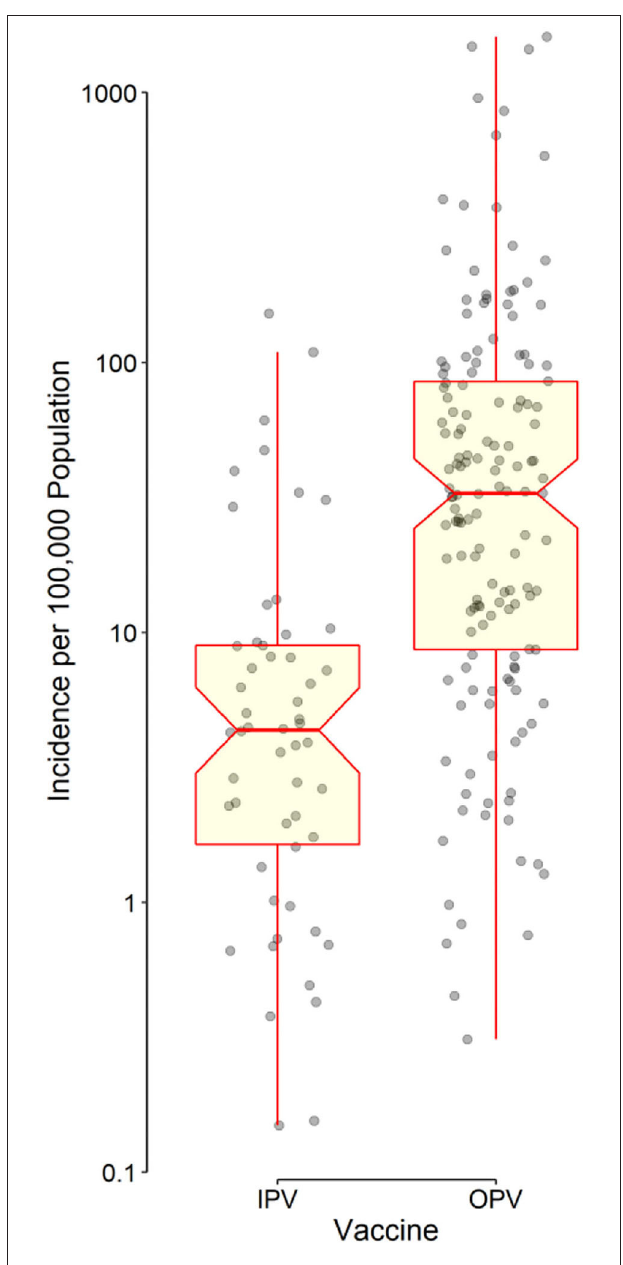
FIGURE 1 | Distribution of data points as well as the box and whisker plot of the incidence of HIV/AIDS in children aged < 1 year stratified by the type of polio vaccine used in each country. The horizontal line in the middle of each box indicates the median. The notch represents the 95% confidence interval of the median. The bottom and top borders of the box show the 25th and 75th percentiles, respectively. The lower whisker indicates the smallest data point within 1.5 times the interquartile range (IQR) less than the 25th percentile; the upper whisker indicates the largest point within 1.5 × IQR greater than the 75th percentile. Points greater than the upper whisker and smaller than the lower whisker were considered outliers. All outliers were included in data analyses. Note that the vertical axis has a logarithmic scale.